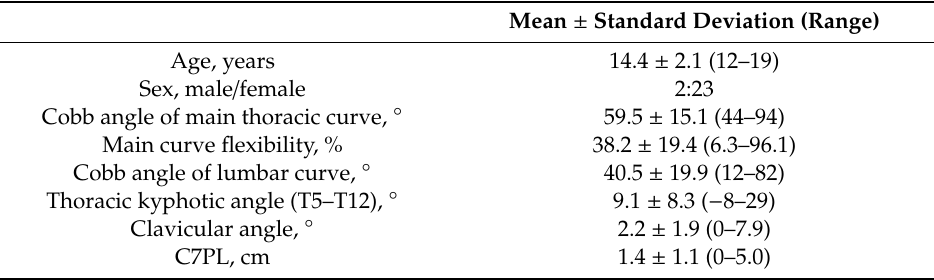
Table 1. Preoperative radiological and clinical features.